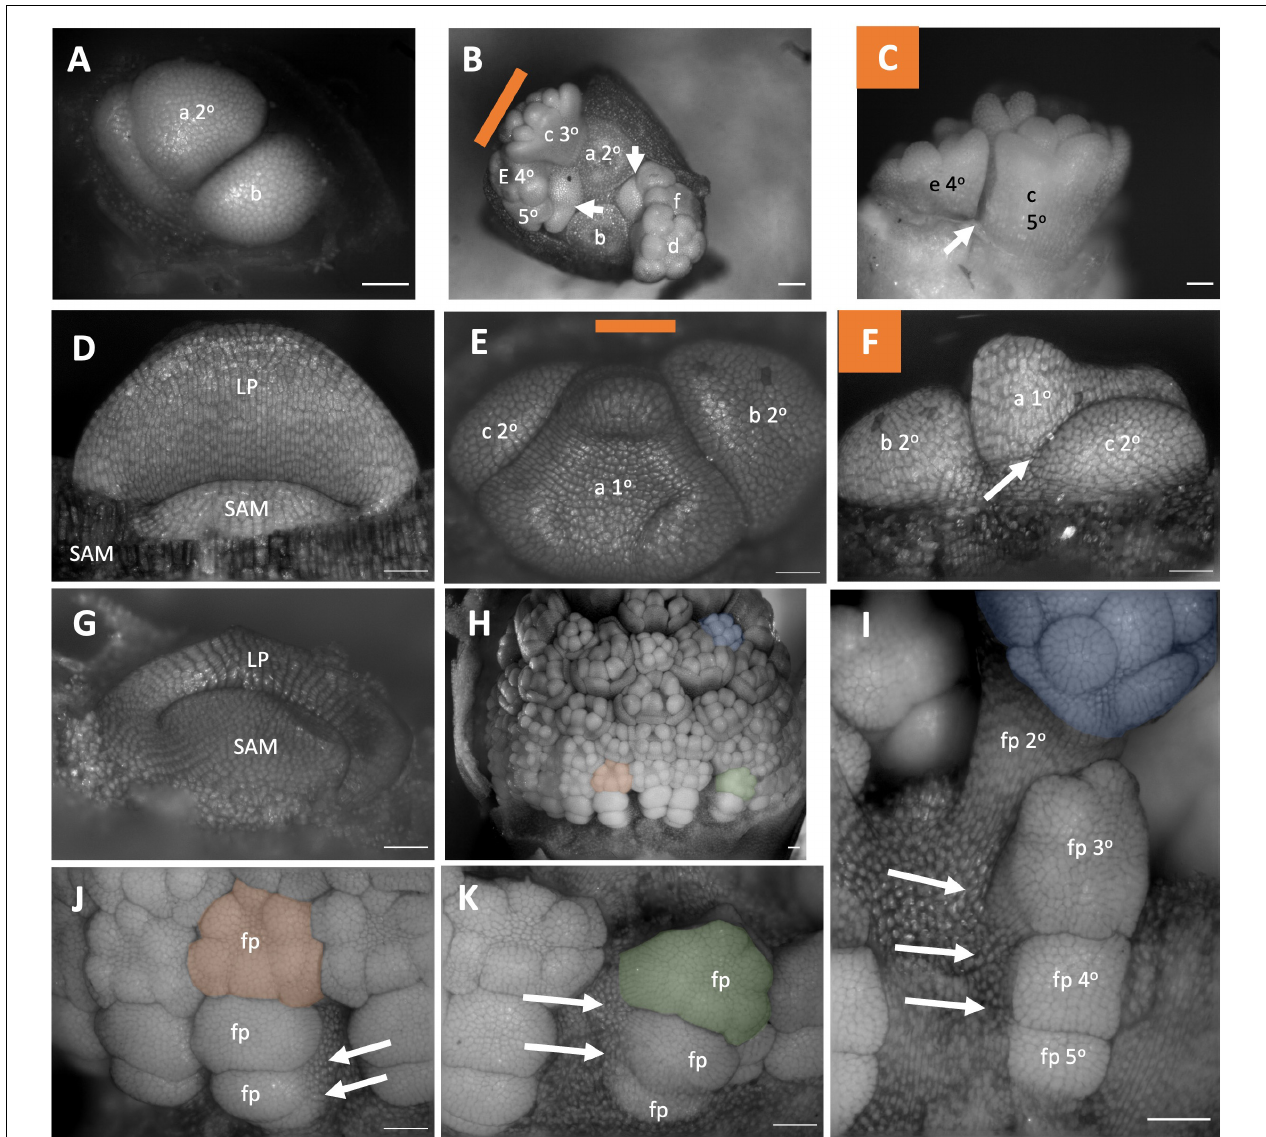
FIGURE 6 | Amaryllidaceae Inflorescence developmental morphology. (A–C) Allium triquetrum (A) Young inflorescence with first two flower primordia. (B,C) Older inflorescence, with the first two flower dissected away, imaged from the apex (B) and laterally (C) . (D–F) Narcissus “martinette” shoot apical meristem (D) and young inflorescence (E,F) . Colored lines on images taken from the apex indicate orientation of the inflorescence in subsequent panels. The first flowers (A–C,E,F) lettered a–f indicating sequence of initiation. Branching order (1 ◦ , 2 ◦ , 3 ◦ ) labeled only for the cyme of the first flower initiated). (G–K) Allium hollandicum. (G) shoot apical meristem. Young inflorescence (H) and close-up of three flower primordia (I–K) false colored for orientation. Branching ordered specified in (I) . Colored lines on images taken from the apex (B,E) indicate orientation of the inflorescence in subsequent panels. SAM, shoot apical meristem; LP, leaf primordia; fp, floral primordia. White arrows indicate branching events. Scale bar for all images: 100 µ